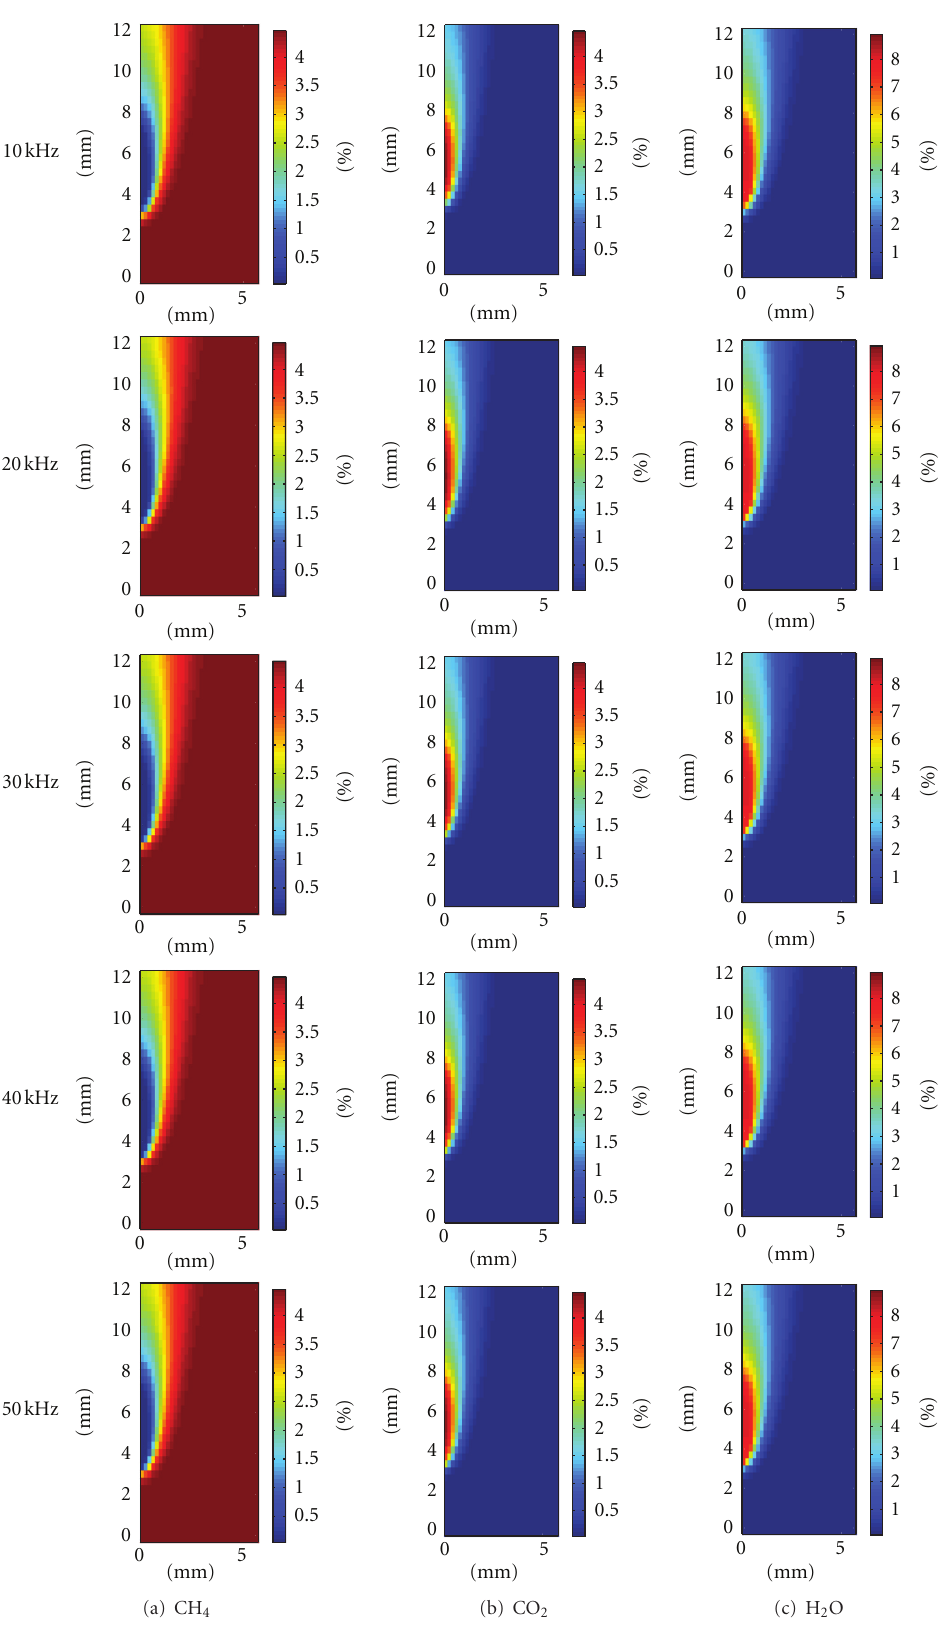
Figure 3: Quasi-steady state spatial distribution of (a) CH 4 , (b) CO 2 , and (c) H 2 O for di ff erent repetition rates of 10kHz, 20 kHz, 30 kHz, 40kHz, and 50kHz at 9 ns pulse